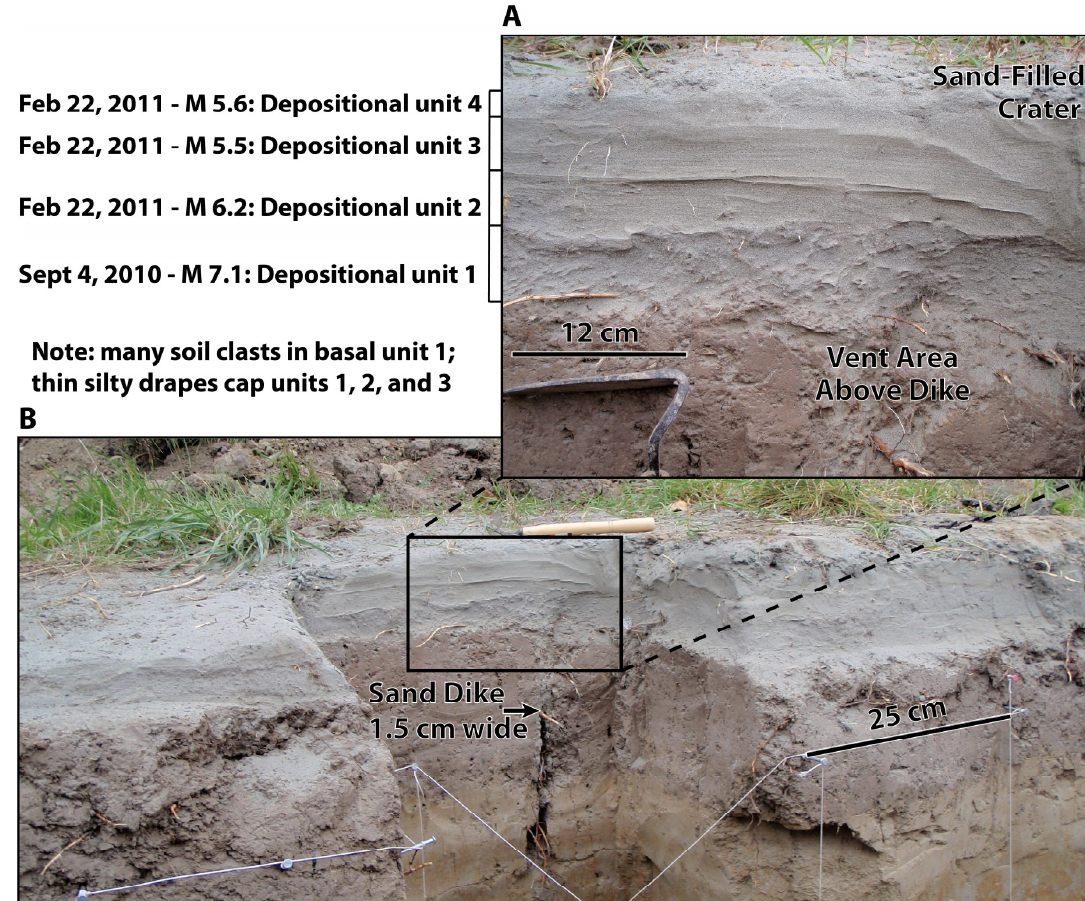
Figure 4. A compound sand blow that formed during September 2010 Darfield and February 2011 Christchurch mainshocks and two aftershocks as exposed in a trench at the Hardwick site south of Christchurch, New Zealand [30]. Photographs by M. Tuttle. ( A ) Closeup of sand blow shows vent area above sand dike, four depositional units of the compound sand blow, and portion of a sand-filled crater. Depositional unit 1 contains soil clasts eroded from the dike wall by venting water and deposited with entrained sand on the ground surface. Depositional units 1, 2, and 3 are composed of sand overlain by silt drapes that stand out in relief. Upper contacts of units 2, 3, and 4 dip toward the sand-blow crater. Upper contacts of units 1 and 4 are irregular, consistent with bioturbation during periods of subaerial exposure. ( B ) Sand blow and related feeder dike; area of closeup in ( A ) indicated by black